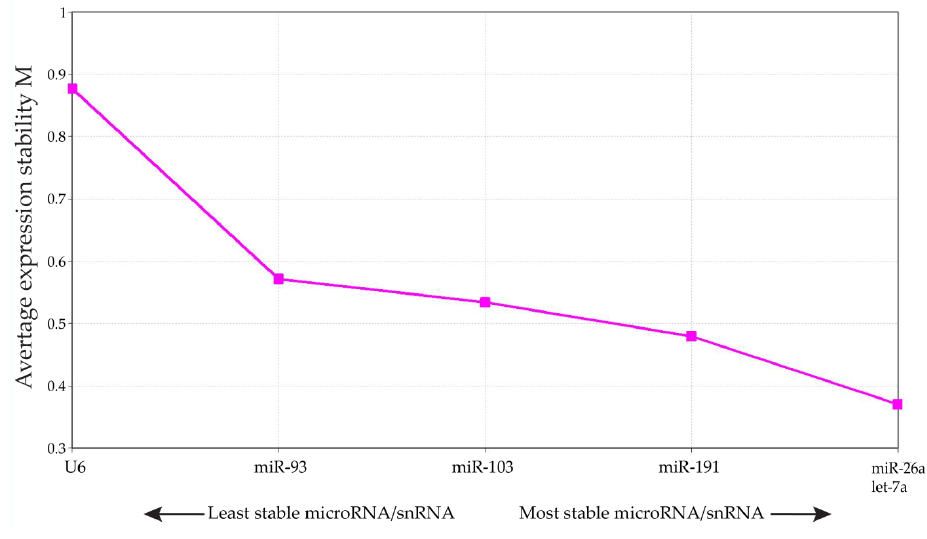
Figure A1. Average expression stability of different mi/snRNAs. Average expression stability (M) of miRNAs/snRNA in bovine cumulus cells. The three miRNAs with the lowest M-values were selected for qRT-PCR normalization.